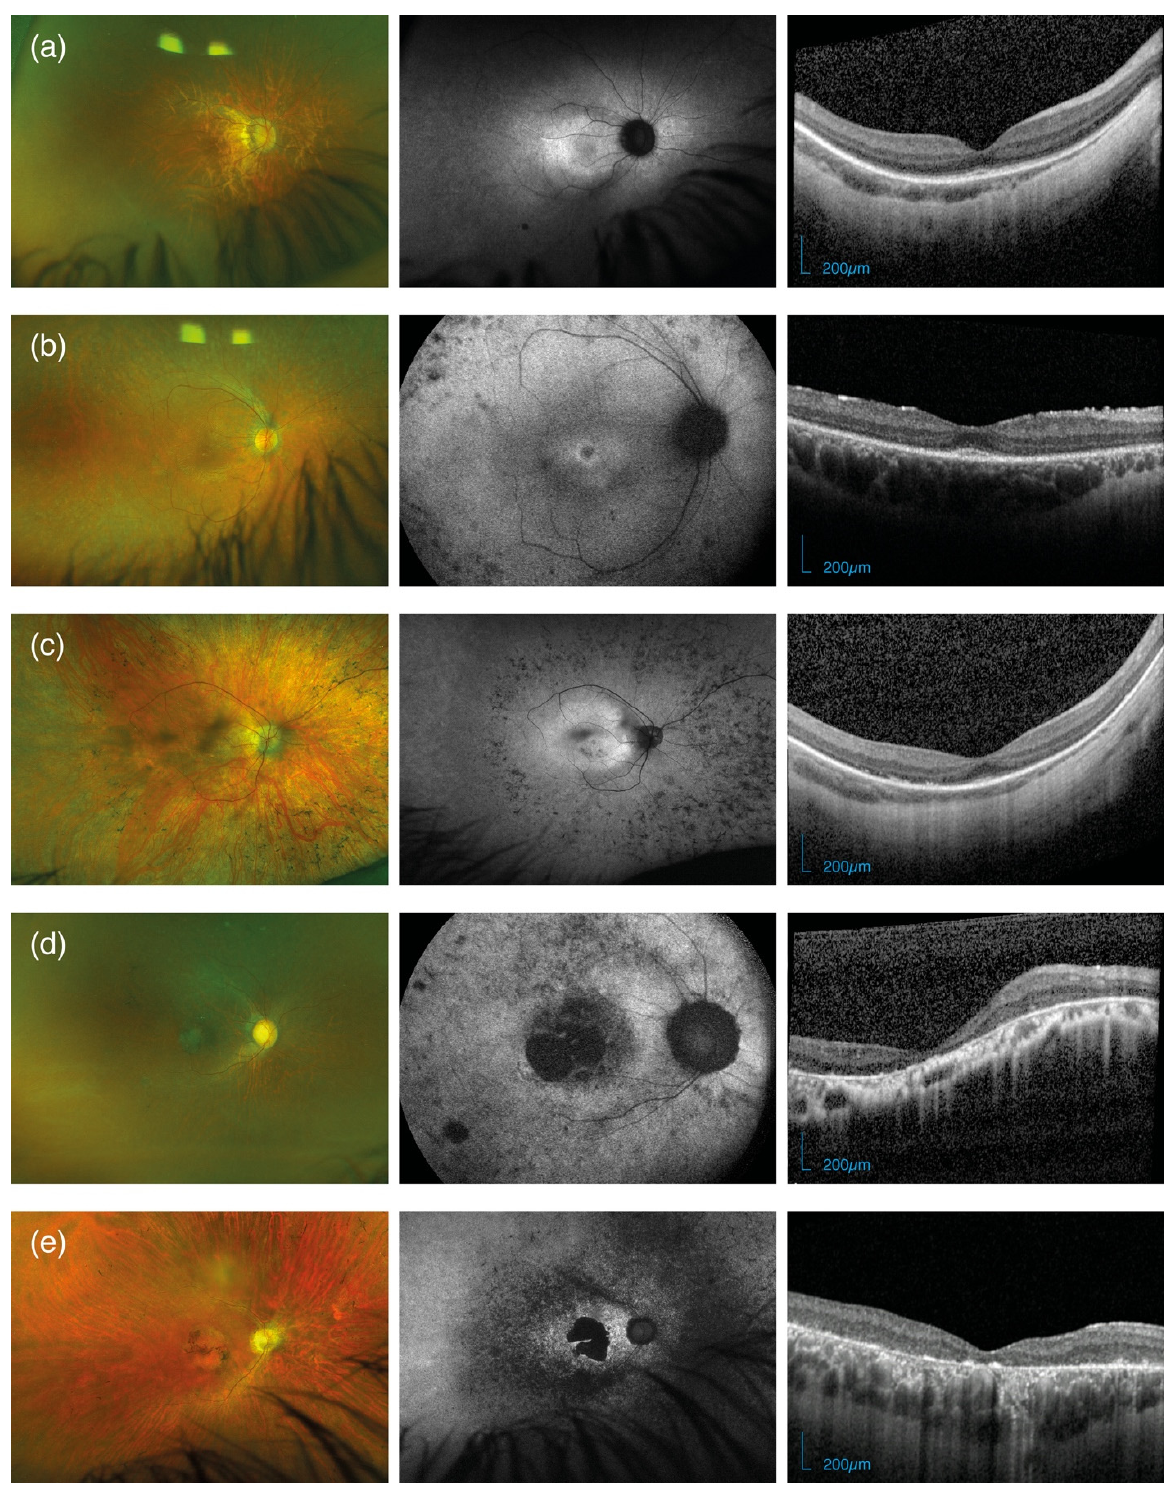
Figure 2. Optos pseudo-colour fundus photos, fundus autofluorescences and SD-OCT scans for five male patients with RP2 -retinopathy with increasing age and severity: ( a ) 12-year-old patient (ID: 15222–3, Table S1) with c.341G>A mutation; ( b ) 15-year-old patient (ID: 20948–3) with c.352C>T mutation; ( c ) 25-year-old patient (ID: 20016–2) with c.14_16delTCT mutation; ( d ) advanced case of a 27- year-old patient with c.685_691del7 mutation (ID: 5284–2) and ( e ) a 31-year-old with c.568_569delinsG mutation (ID: 49–2).